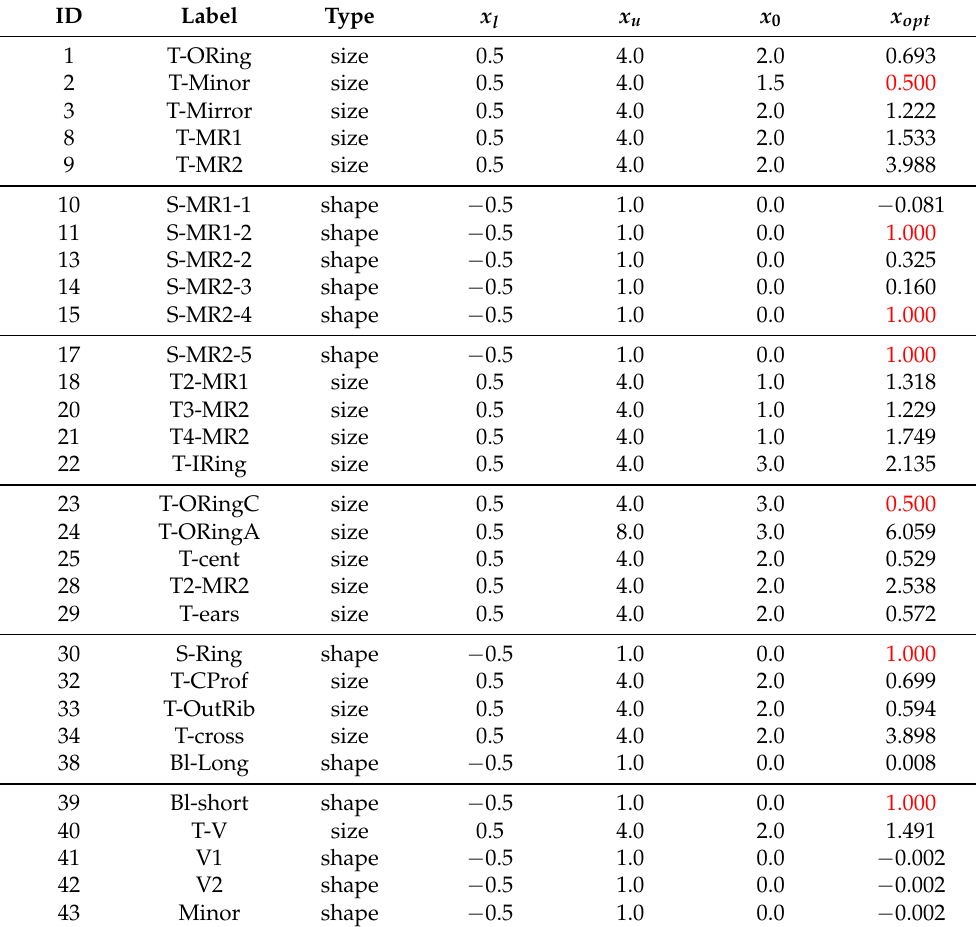
Table 2. Design variables at starting point x 0 and at found “local” optimum x opt with their corre- sponding bounds (lower x l and upper x u